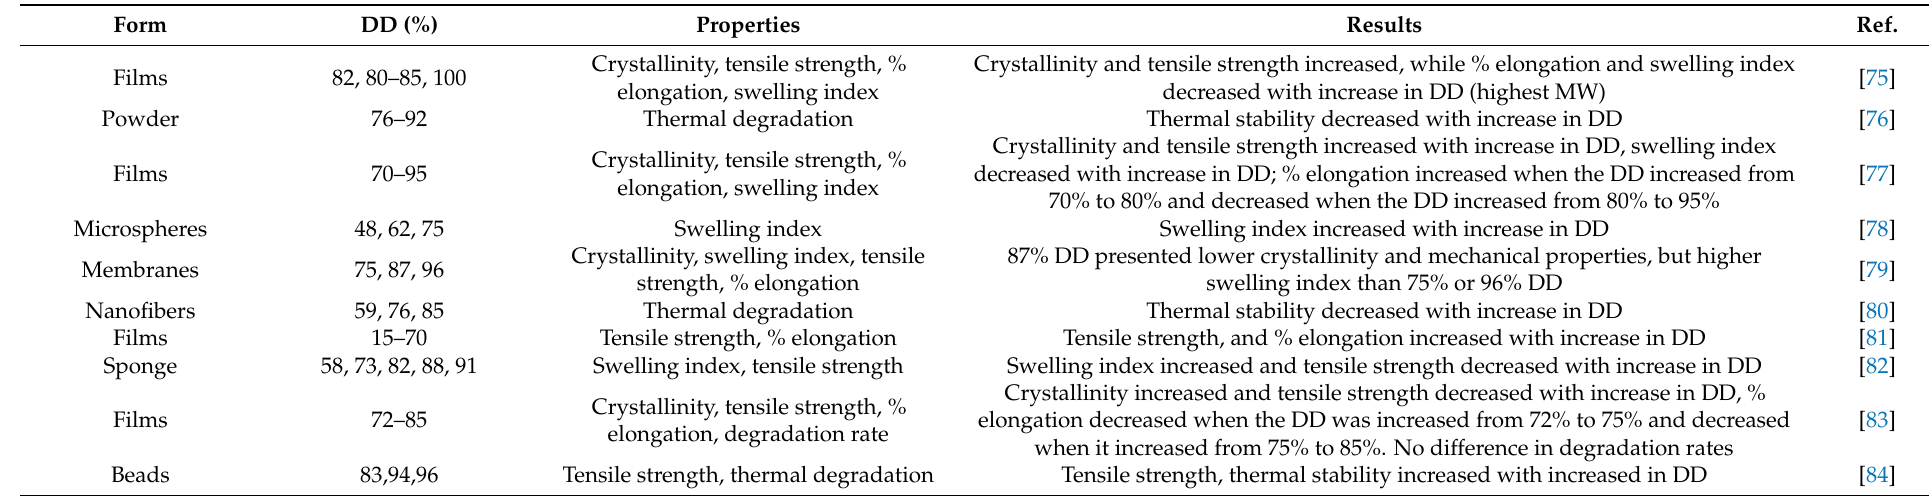
Table 2. Influence of deacetylation degree (DD) on physicochemical properties of chitosan in different